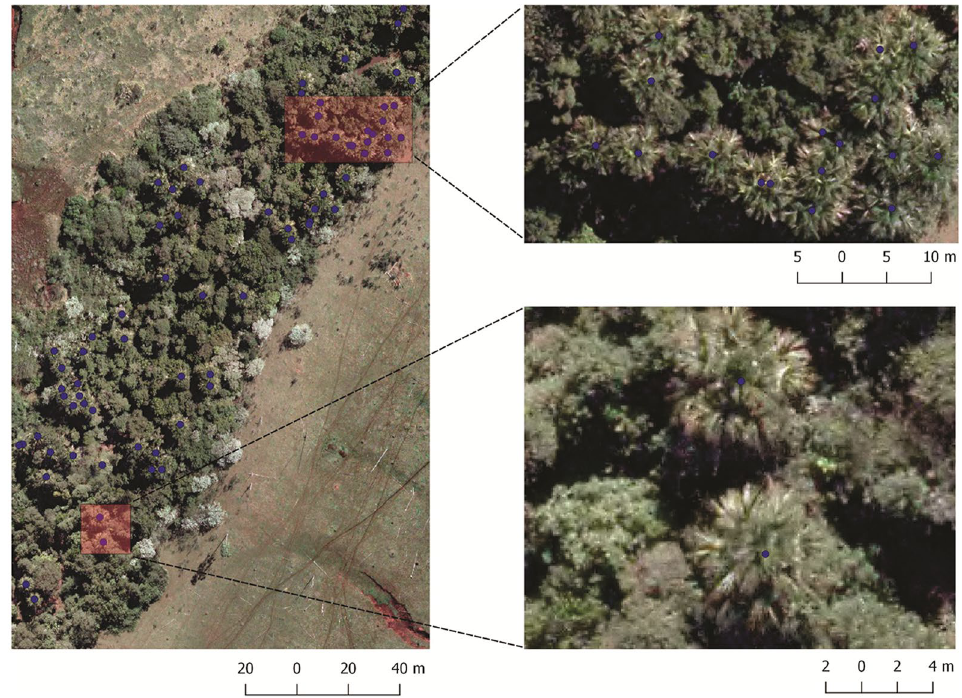
Figure 6. Examples of the labeled dataset. M. flexuosa palm trees are represented with blue